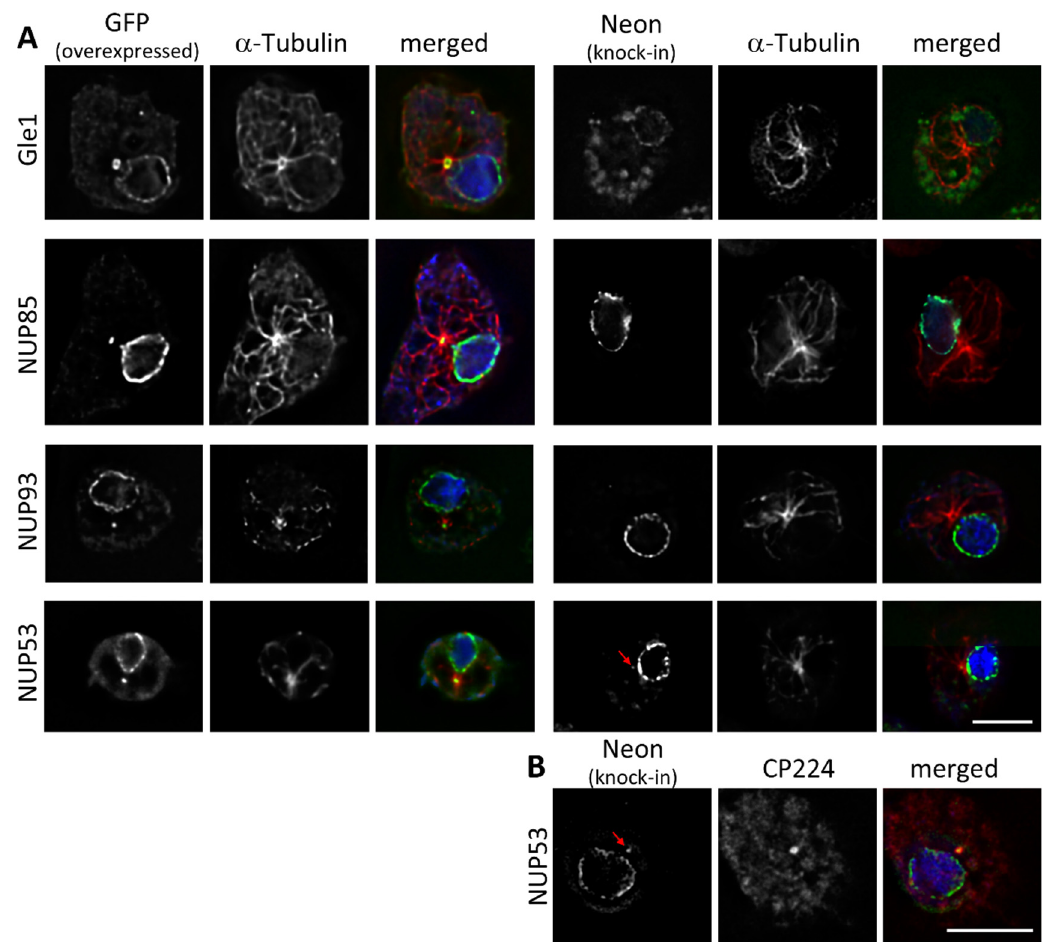
Figure 3. Centrosomal localization of overexpressed Gle1, NUP53, NUP85 and NUP93. At endogenous expression levels only NUP53 ‐ neon can be found at the centrosome (red arrow). Immunofluorescence microscopy of GFP ‐ NUP (overexpressed, left side) or NUP ‐ Neon (knock ‐ in, right side) expressing cells in interphase fixed with glutaraldehyde, stained with either anti ‐α‐ Tubulin and secondary antibody anti ‐ rat ‐ AlexaFluor ‐ 568 ( A ) or anti ‐ CP224 and secondary antibody anti ‐ rabbit ‐ AlexaFluor ‐ 568 ( B ). Only the one focus plane containing the centrosome is presented. Overlay of the Green Fluorescent Protein signal (green) with α‐ Tubulin or CP224 (red) and DAPI (blue). Bar = 5 μ m.